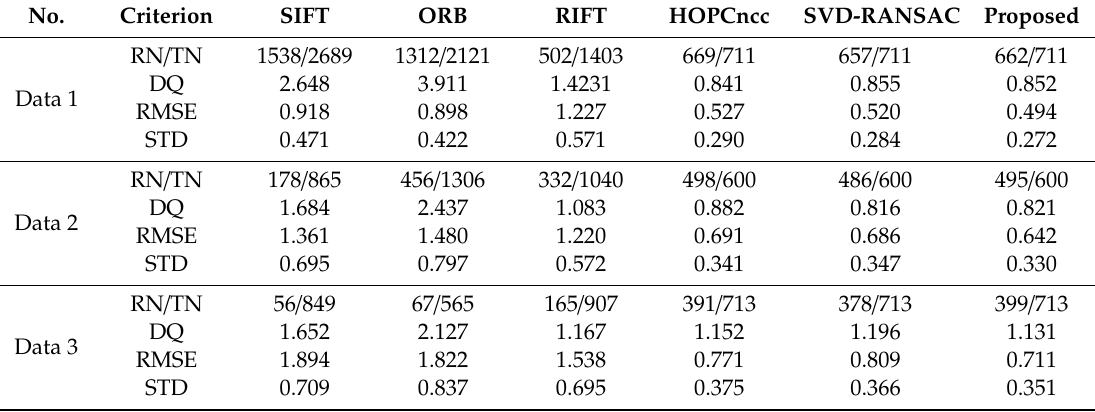
Table 5. Registration performance of di ff erent methods. TN, the number of total matches; RN, the number after outlier removal. The unit of RMSE and STD is